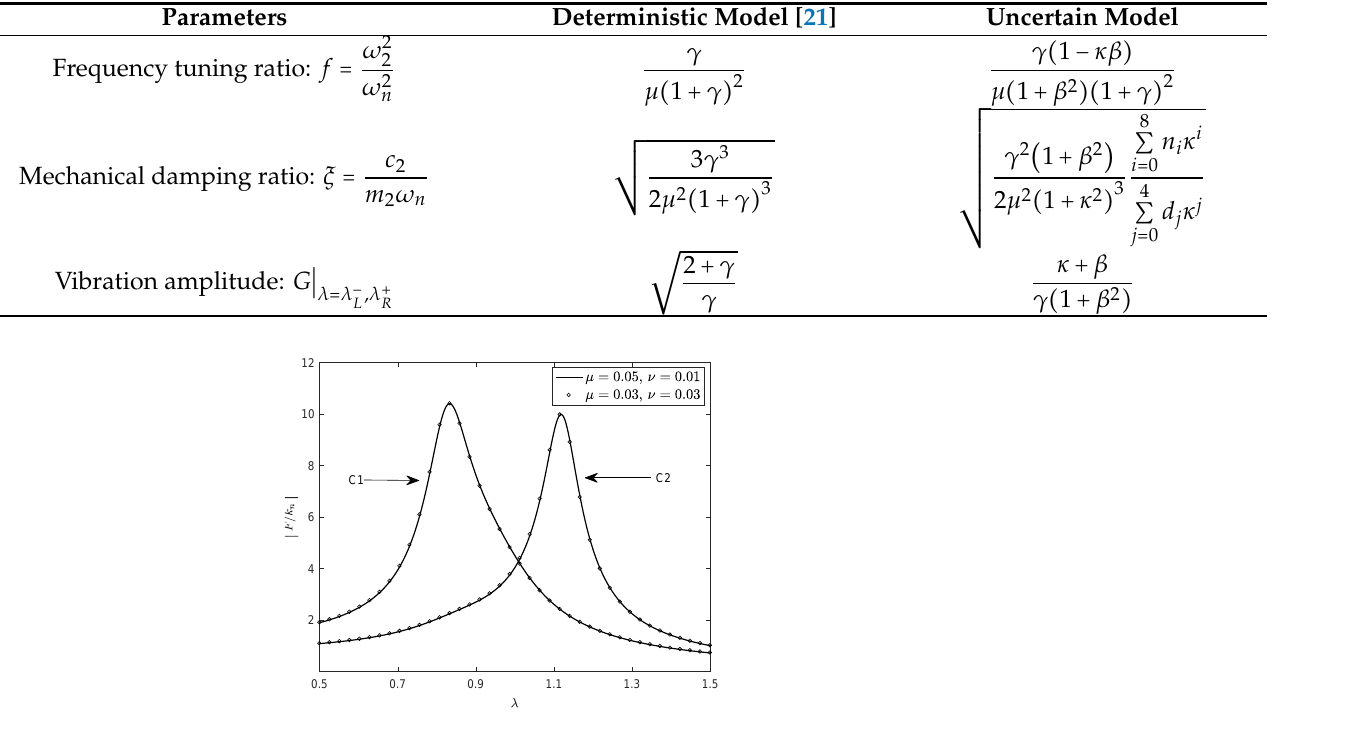
Table 1. Optimal parameters of TMDIs for controlling the vibration of a harmonically forced host structure in both deterministic and uncertain scenarios. Constants n i , i = 0,1,. . .,8 and d j , j = 0,1,. . .,4 are given in Equations (45) and (46), with γ = µ + ν and κ =